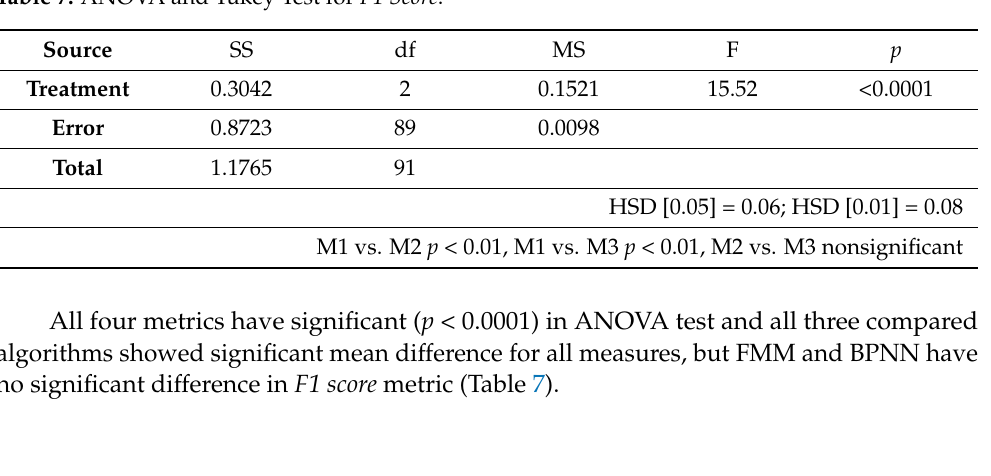
Table 7. ANOVA and Tukey Test for F1 Score